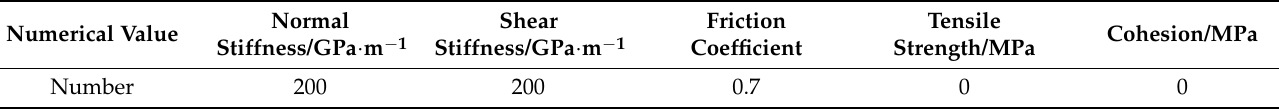
Table 3. Mesoscopic parameters of smooth joints model.